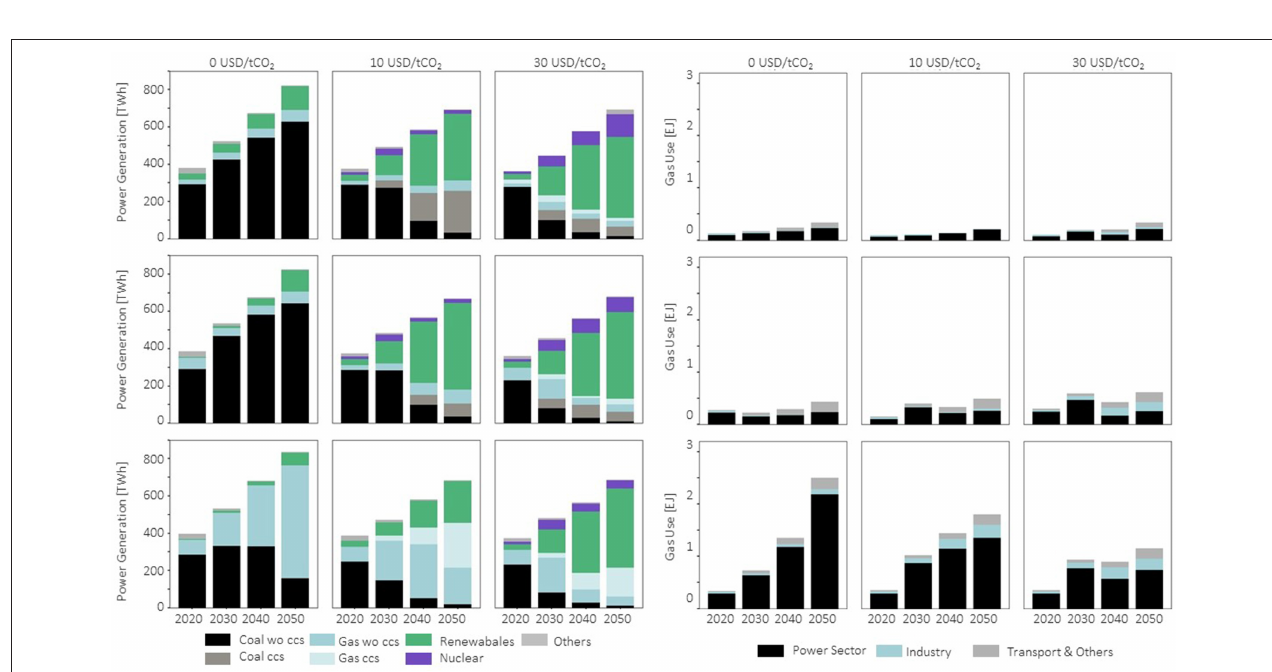
FIGURE 4 | (Left) Energy-related GHG emissions at seven selected carbon prices relative to the zero carbon price scenario in the no-shale gas scenarios. The NDC pledge is shown as the gray shaded area. (Right) Energy-related GHG emissions at seven selected carbon prices under various gas extraction costs. The lines indicate the no-shale-gas scenarios, the shaded areas indicate the emissions range if shale gas is available at various extraction costs. The figure shows that shale gas utilization can decrease emissions at low carbon prices, but increases them at moderate to high carbon price levels. The gray shaded area shows South Africa’s NDC reduction pledge (UNFCCC, 2015).